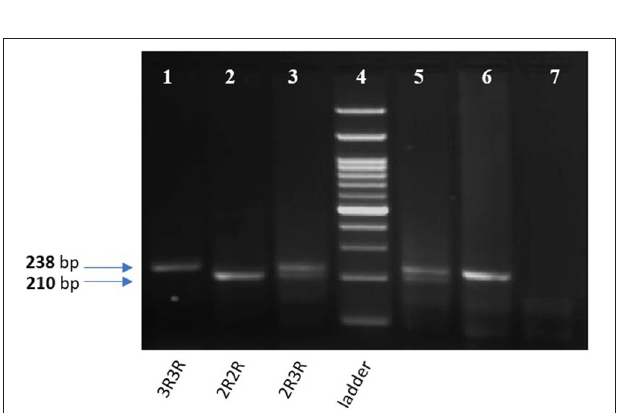
FIGURE 3 | 2% gel for TYMS 28bp tandem repeat PCR products. Lane 1,6: TYMS 3R homozygous repeat (238 bp). Lane 2: TYMS 2R homozygous repeat (210 bp). Lan 3,5: TYMS 2R3R heterozygous (210 and 238 bp). Lane 7: A non-template (negative control). Lane 4: 100 bp DNA